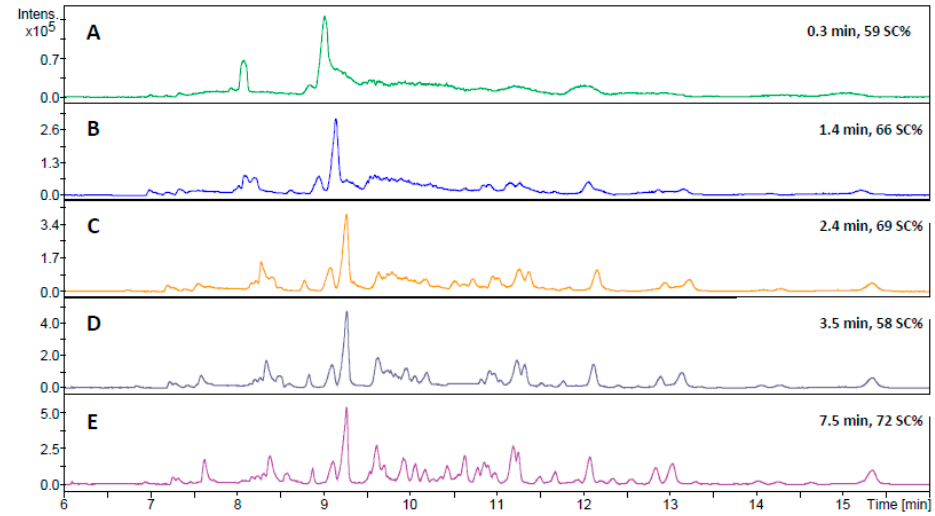
Figure 3. CZE-MS measurements after in-line digestion of human serum albumin with increasing contact times (0.3 min–7.5 min). The approximate contact times and the sequence coverage% values obtained are shown on the right. Conditions were the same as in Figure 1. But BGE: 40 mM NH 4 Ac, pH = 8; trypsin solution: 20 mg/mL, pH = 4; fused silica capillary: 90 cm length; injection parameters were 50 mbar for 6 s ( A ); sample: 50 mbar for 6 s, then BGE: 15 mbar for 60 s ( B ); sample: 50 mbar for 6 s, then BGE: 120 s for 15 mbar ( C ); sample: 50 mbar for 6 s, BGE: 15 mbar for 60 s, 60 s waiting, and then 15 mbar for 60 s ( D ); sample: 50 mbar for 6 s, then BGE: 15 mbar for 60 s, 300 s waiting, and then 15 mbar for 60 s ( E ). MS: positive ionization mode; spectra rate: 8 Hz; MS/MS frequency: 1–4 Hz; nebulizer pressure: 0.5 bar; dry gas temperature: 180 °C; sheath-liquid: IPA: water = 1:1 + 0.1% HAc.